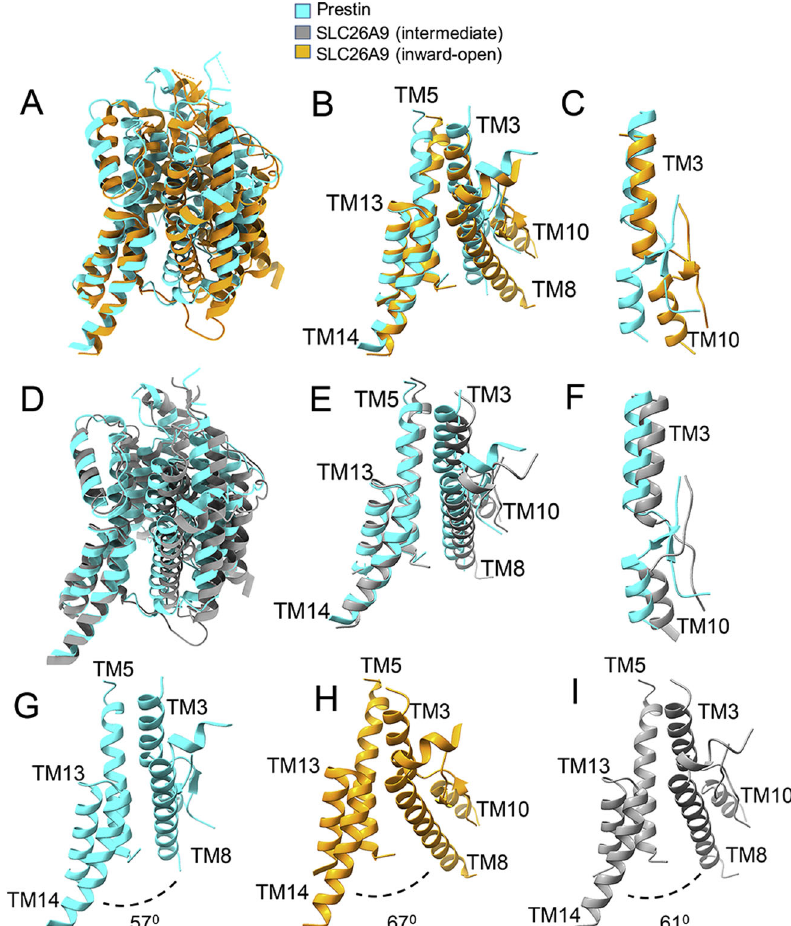
Fig. 2 Comparison of the transmembrane regions between the prestin structure and the Slc26a9 structure (in two different conformations). A Superposition of the transmembrane-domain structures of prestin (colored in cyan) and Slc26a9 in the “ inward-open ” conformation (colored in orange, PDB 7CH1). The structures have been superimposed through the TM13 and TM14 helices from the “ gate ” domain. B Close-up view showing a portion (TM3, TM5, TM8, TM10, TM13 and TM14 helices) of the overlaid transmembrane domains (as shown in panel A ). C Close-up view of the overlaid pair of helices (TM3 and TM10) from the two structures in the orientations shown in panel A . D Superposition of the transmembrane domain structures of prestin (colored in cyan) and Slc26a9 in the intermediate conformation (colored in gray, PDB 6RTF) (superimposed through the gate ’ s TM13 and TM14 helices). E Close-up view of the overlaid (TM3, TM5, TM8, TM10, TM13, and TM14) helices from the two structures in the orientations shown in panel ( D ). F Close- up view showing the offset between the pair of helices (TM3 and TM10) from the two structures in the orientations shown in panel ( D ). G – I Side-by-side comparisons of the opening between the TM8 helix (from the core domain) and the TM14 helix (from the gate domain) on the intracellular side of the membrane for the three structures. Consistent with the expectation, this opening (de fi ned by the angle between the TM8 helix and TM14 helix) is the larger in the Slc26a9 structure (inward-open conformation) and the smaller in the prestin structure. The angle between TM8 and TM14 helices of prestin and of Slc26a9 is 57° (for prestin), 61° (for Slc26a9, the intermediate conformation), and 67° (for Slc26a9, the “ inward-facing ” , open conformation). See also Supplementary Fig.